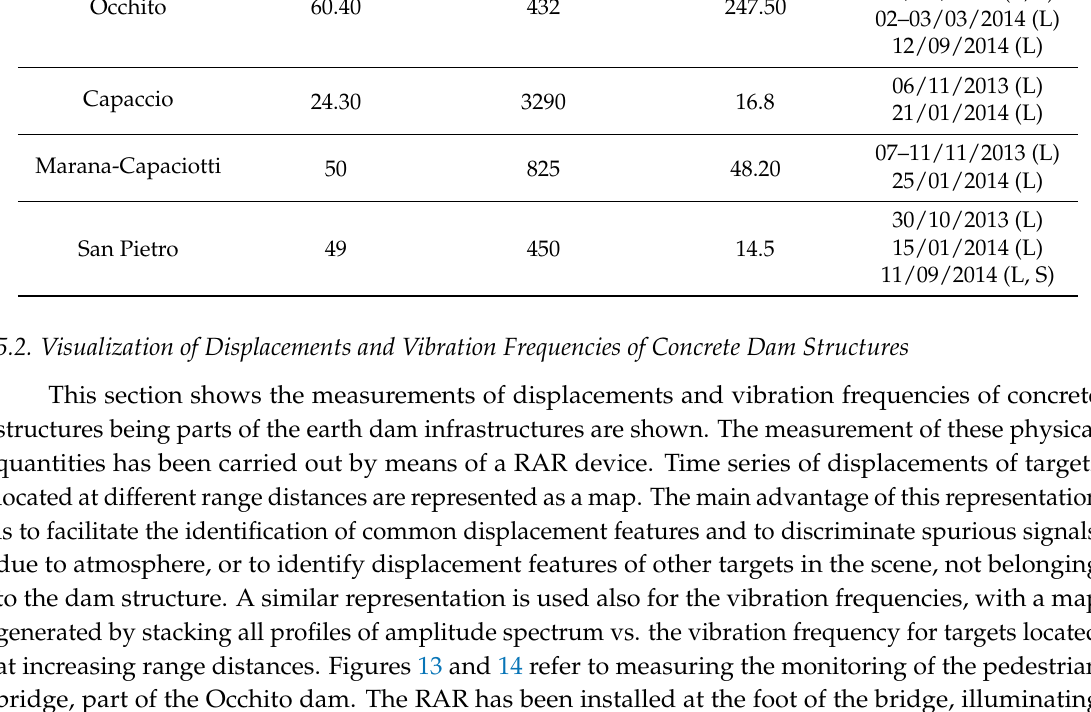
Figure 12. San Pietro dam, Aquilonia. ( a , b ) photo of the dam as observed from the GBSAR positions; ( c , d ) interferometric coherence; ( e , f ) displacement maps in Cartesian coordinates. Data have been collected by two GBSAR systems installed on upper (UP) and downstream (DOWN) sides of the dam, respectively.